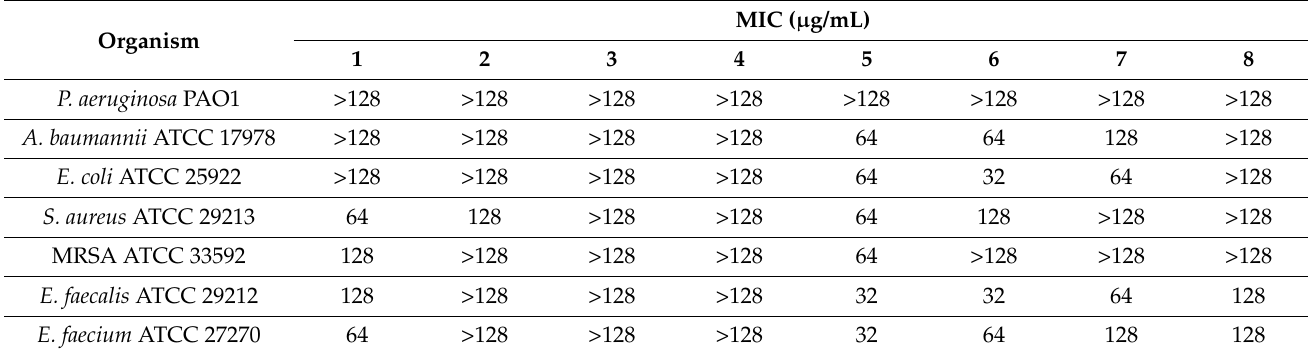
Table 1. Antibacterial activity of UTBLPs 1 – 8 against wild-type GNB and wild-type